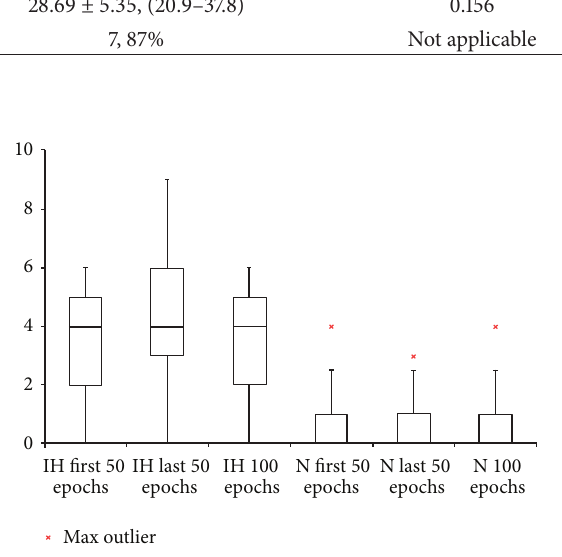
Figure 1: Box-plot comparison of sleep spindle index in idiopathic hypersomnia (IH) and narcolepsy (N). Max: